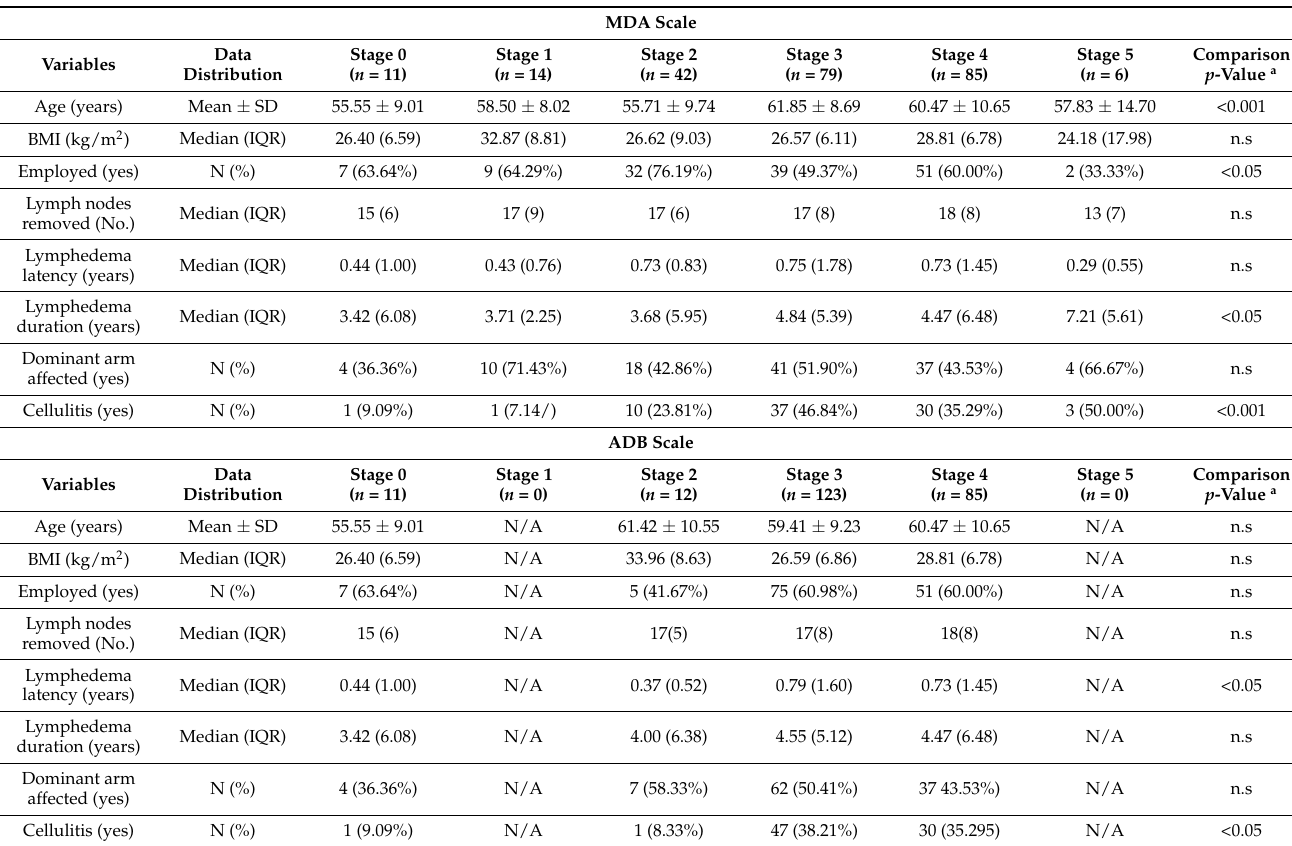
Table 4. This table shows the patient characteristics stratified by the MDA and ADB scales. n = number of patients, No. = number, a = Stage 0–2 vs. 3–5, n.s = not